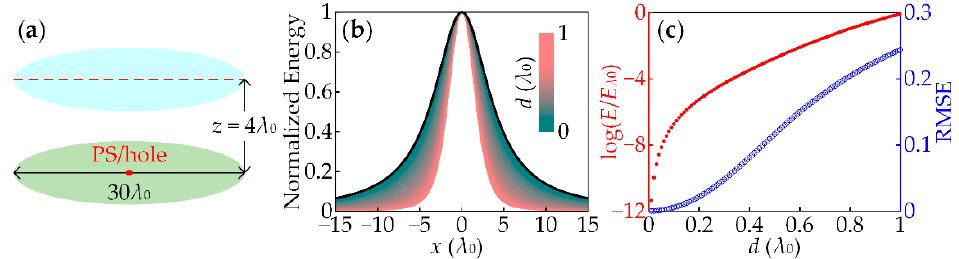
Figure 3. Mimicking of a PS by a small hole. ( a ) Illustration for a simulation model of PS